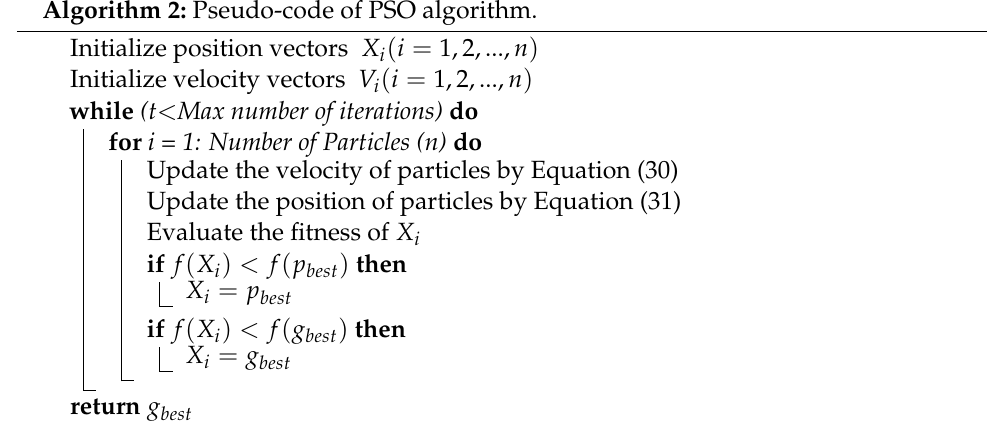
Algorithm 2: Pseudo-code of PSO